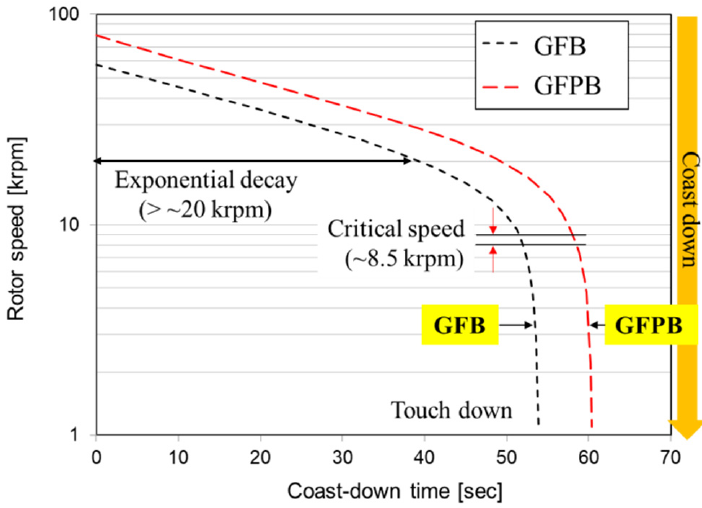
Figure 12. Measured rotor speed versus time during the coast-down process for GFB and GFPB.